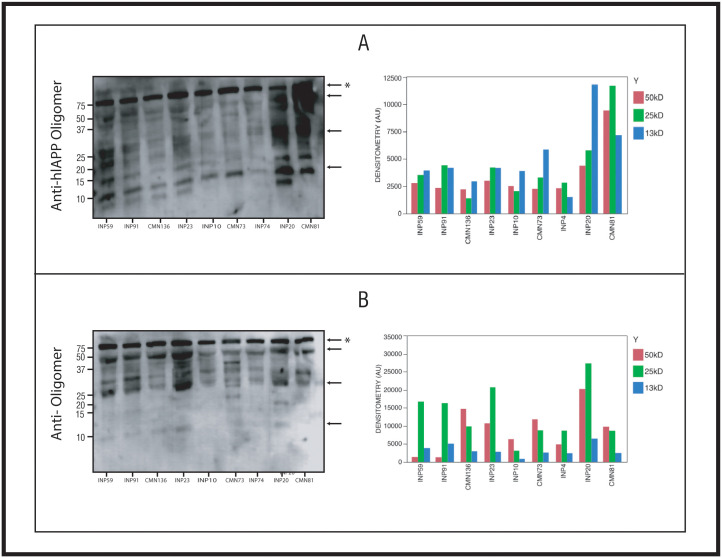
Riao characterization.Western blot analysis of PTS of pediatric patients (30 μg of total protein/lane. A) PTS reacting to the anti-hIAPP cytotoxic oligomer polyclonal antibody. B) PTS reacting to the anti-oligomers (A11). Codes of samples: INP59:T1DM, INP91:T1DM, CMN136: Healthy child, INP23:T1DM, INP10: T1DM, CMN73:T2DM, INP4:T1DM, INP20:T1DM, CMN81:obesity. Detection of transferrin was used as a loading control (*). The numbers on the left correspond to the molecular weight of the bands (kDa). The 50 kDa and 25 kDa markers were the most abundant. Densitometric analysis of the samples for the kDa bands of 50, 25, and 13 kDa. The amount of RIAO found in each of these bands for these three molecular weights is shown.